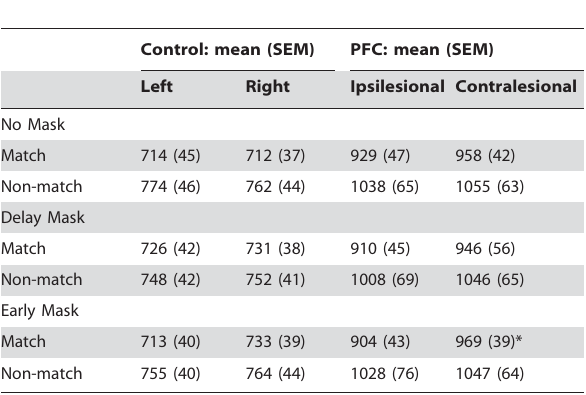
Table 2. Summary of Reaction